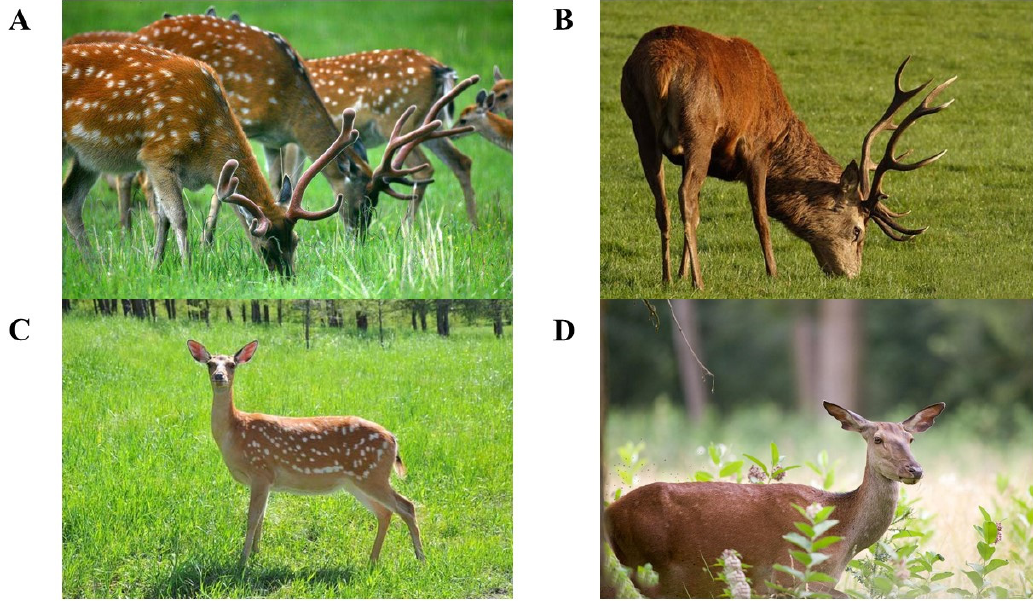
Figure 1. ( A ) Male sika deer. ( B ) Male wapiti. ( C ) Female sika deer. ( D ) Female